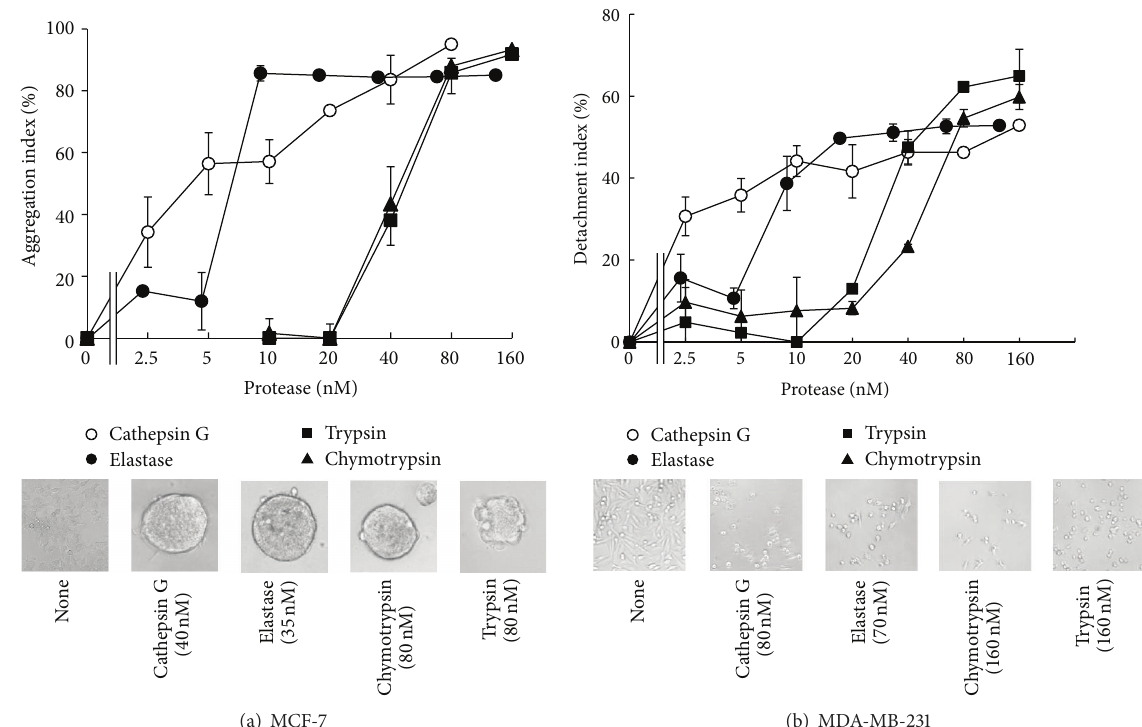
Figure 2: Effect of serine proteases on the adherence capacity of preadhered mammary carcinoma cells. (a) Induction of spheroidal aggregation by proteases against MCF-7 cells. (b) Induction of the loss of tight adhesion to culture substrates by serine proteases against MDA MB-231 cells. ((a), (b)) MCF-7 cells or MDA MB-231 cells were seeded in 96-well plates in RPMI 1640 medium containing 5% FBS. The cells were cultured overnight and the adherent cells were incubated with cathepsin G ( I ), neutrophil elastase ( e ), chymotrypsin ( 󳵳 ), or trypsin ( ◼ ) containing 1% BSA-medium for 24 h. After washing, residual cells were stained with crystal violet, and the aggregation index (a) or the detachment index (b) was calculated as described in Section 2. The results are expressed as mean ± SD ( 𝑛 = 3 ). When the bars are not shown, they are smaller than the size of the symbols. Lower photos: images of MCF-7 cells (left) and MDA MB-231 cells (right) at 24 h after incubation with the serine proteases. Original magnification: ×